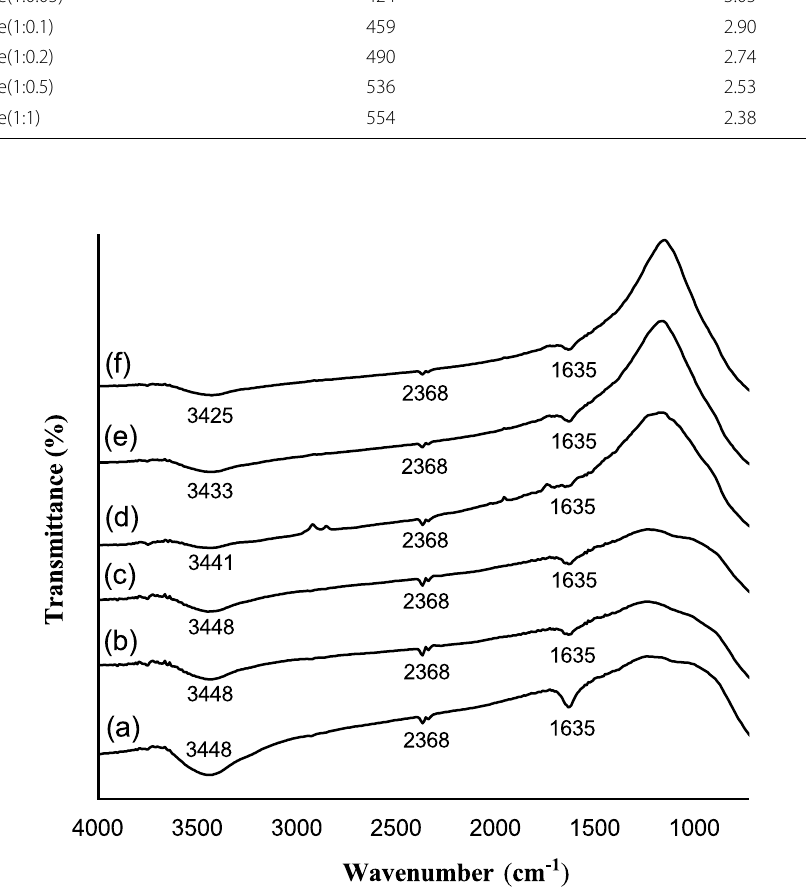
Fig. 4 FTIR spectra of a TiO 2 , b TiO 2 –Fe(1:0.05), c TiO 2 –Fe(1:0.1), d TiO 2 –Fe(1:0.2), e TiO 2 –Fe(1:0.5), and f TiO 2 – Fe(1